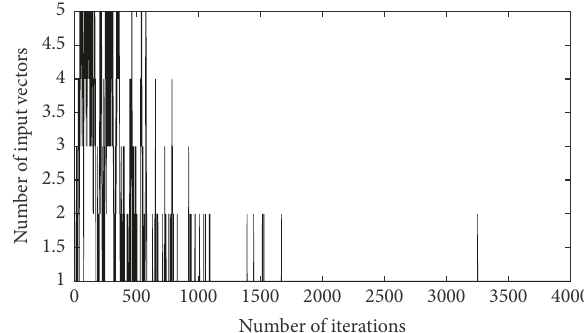
Figure 4: Zoomed view of the number of input vectors used in the proposed FXECAP-L algorithm when 𝐿 = 5 and 𝑏 = 2